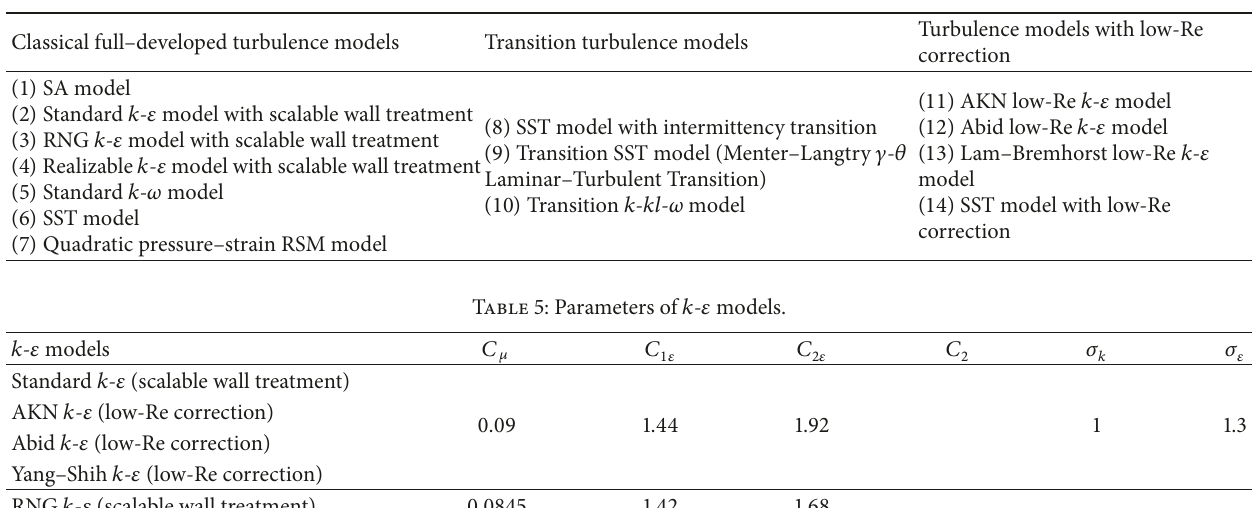
Table 4: Turbulence models.